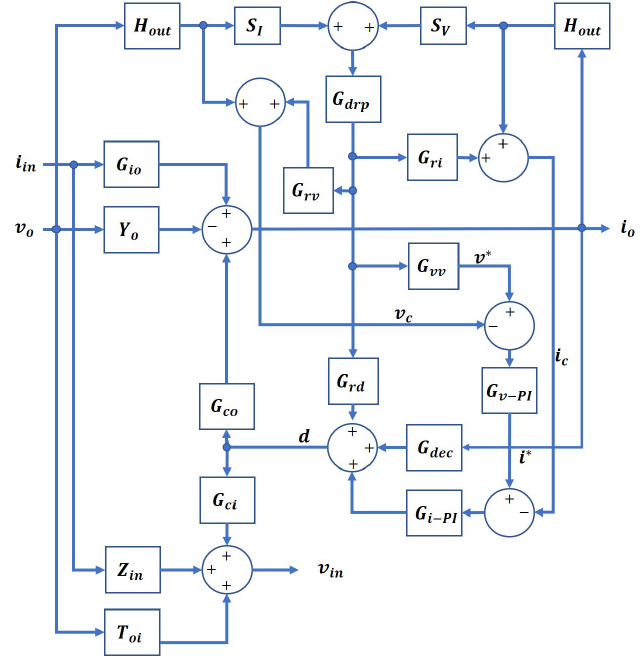
Figure 8. Transfer function representation of input and output dynamics for nested-loop controller with droop [89].